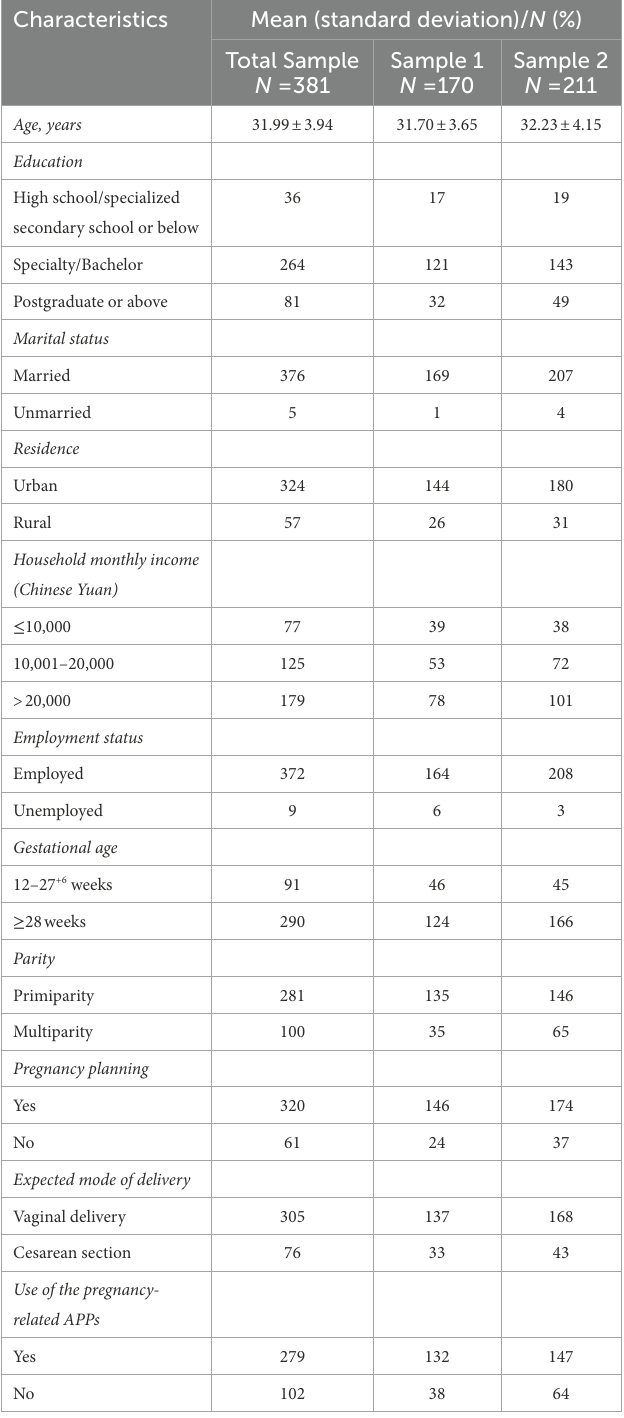
TABLE 1 Characteristics of the included participants ( N =